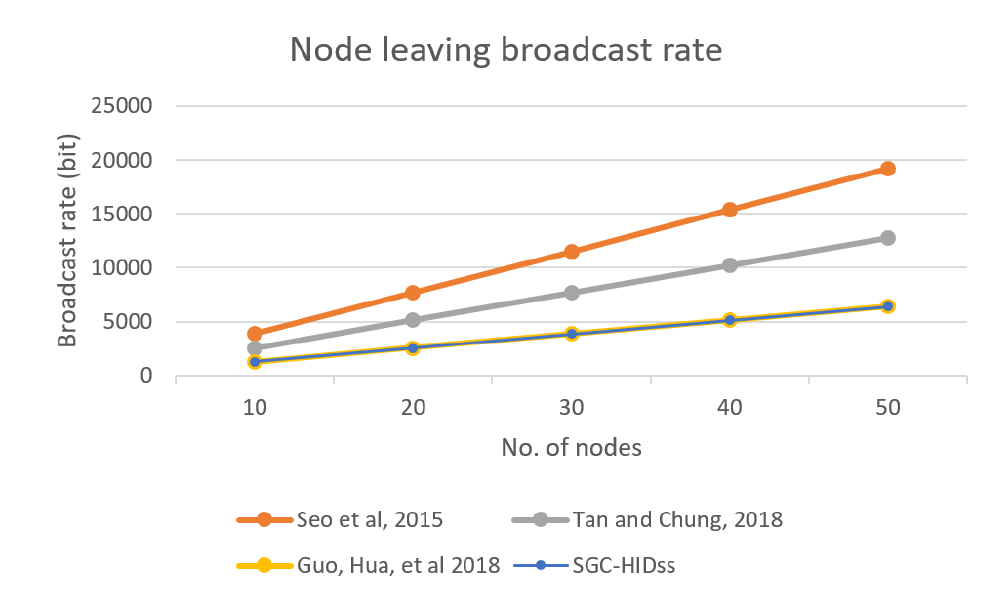
Figure 9. BS broadcast rate for each node leaving the group.